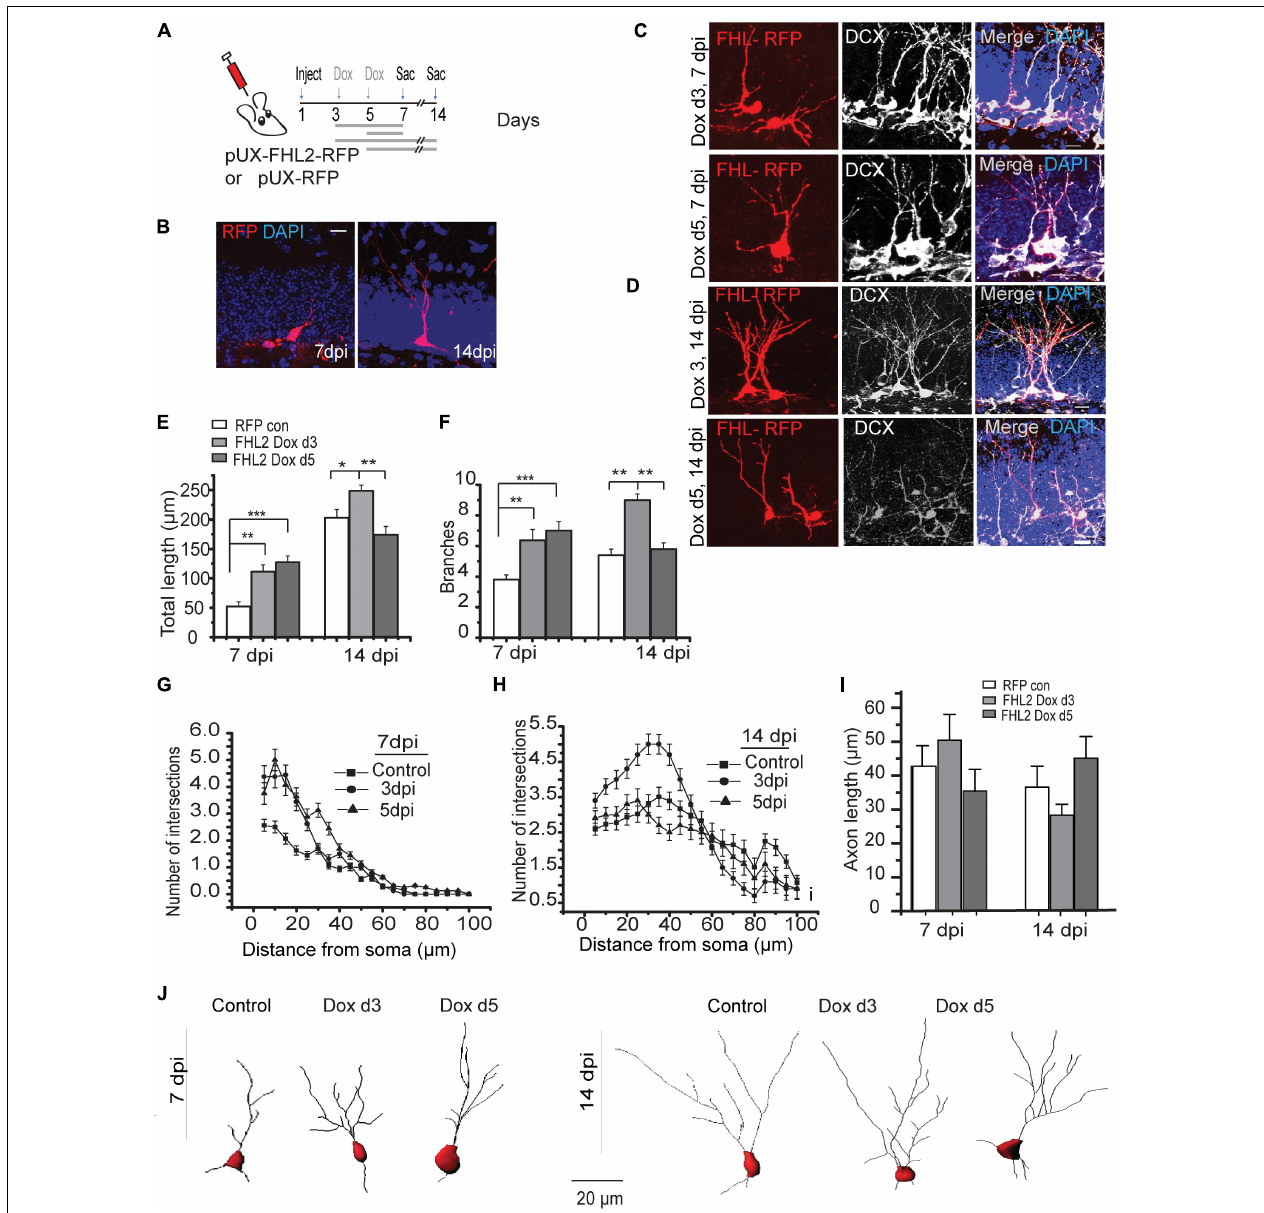
FIGURE 4 | Overexpression of FHL2 expands dendritic outgrowth in adult-born DGCs. (A) Experimental timeline of inducible FHL2 overexpression, with doxycycline induction (dox) at 3 or 5 dpi and sacrifice (sac) at 7 or 14 dpi. (B) Representative images of control DGCs expressing RFP (RFP con) at 7 and 14 dpi. Scale bar, 10 µ m. (C) Representative images of FHL2-overexpressing cells co-labeled with DCX at 7 dpi, induced at either 3 dpi (top) or 5 dpi (bottom). Scale bar, 10 µ m. (D) Representative images of FHL2-overexpressing cells co-labeled with DCX at 14 dpi, induced at either 3 dpi (top) or 5 dpi (bottom). Scale bar, 10 µ m. (E) Quantification of total dendrite length at 7 and 14 dpi for control cells expressing RFP only, and FHL2-overexpressing cells induced at 3 or 5 dpi ( n = 116 cells). 7 dpi: One-way ANOVA F (2,45) = 9.162, P < 0.0001, followed by post hoc Tukey HSD test: RFP con vs. FHL2 Dox d3, P < 0.01; RFP con vs. FHL2 Dox d5, P < 0.001. 14 dpi: One-way ANOVA F (2,120) = 8.58, P < 0.0001, followed by post hoc Tukey HSD test: RFP con vs. FHL2 Dox d3, P < 0.05; FHL2 Dox d3 vs. FHL2 Dox d5, P < 0.01. (F) Quantification of number of dendritic branch points at 7 and 14 dpi for control cells expressing RFP only, and FHL2-overexpressing cells induced at 3 or 5 dpi ( n = 116 cells). 7 dpi: One-way ANOVA F (2,45) = 9.162, P < 0.0001, followed by post hoc Tukey HSD test: RFP con vs. FHL2 Dox d3, P < 0.01; RFP con vs. FHL2 Dox d5, P < 0.001. 14 dpi: One-way ANOVA F (2,120) = 26.79, P < 0.0001, followed by post hoc Tukey HSD test: RFP con vs. FHL2 Dox d3, P < 0.01; FHL2 Dox d3 vs. FHL2 Dox d5, P < 0.01. (G) Sholl analysis at 7 dpi. Two-way ANOVA F (2, 44) = 6.814, p = 0.003, con vs. FHL2 Dox d3, p = 0.05, control vs. FHL2 Dox d5, p = 0.02, FHL2 Dox d3 vs. FHL2 Dox d5 p = 0.427. (H) Sholl analysis at 14 dpi: Two-way ANOVA F (2, 120) = 4.107, p = 0.01, followed by post hoc Tukey HSD test: RFP con vs. FHL2 Dox d3, p = 0.036, control vs. FHL2 Dox d5, p > 0.05, FHL2 Dox d3 vs. FHL2 Dox d5 p < 0.05. (I) Quantification of axonal length at 7 and 14 dpi for control cells expressing RFP only, and FHL2-overexpressing cells induced at 3 or 5 dpi. 7 dpi: One-way ANOVA F (2,57) = 1.23, p = 0.299.14 dpi: One-way ANOVA F( 2,57) = 2.38, p = 0.102. N = 3–4 mice per condition. Data are presented as mean + SEM. (J) Representative dendritic tracing of control cells expressing RFP only and FHL2-overexpressing cells dox d3 and dox d5 at 7- and 14 dpi, scale bar, 20 µ m.